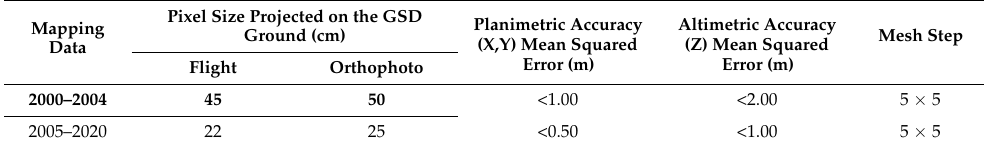
Table 2. Technical characteristics of georeferenced data used. Mapping